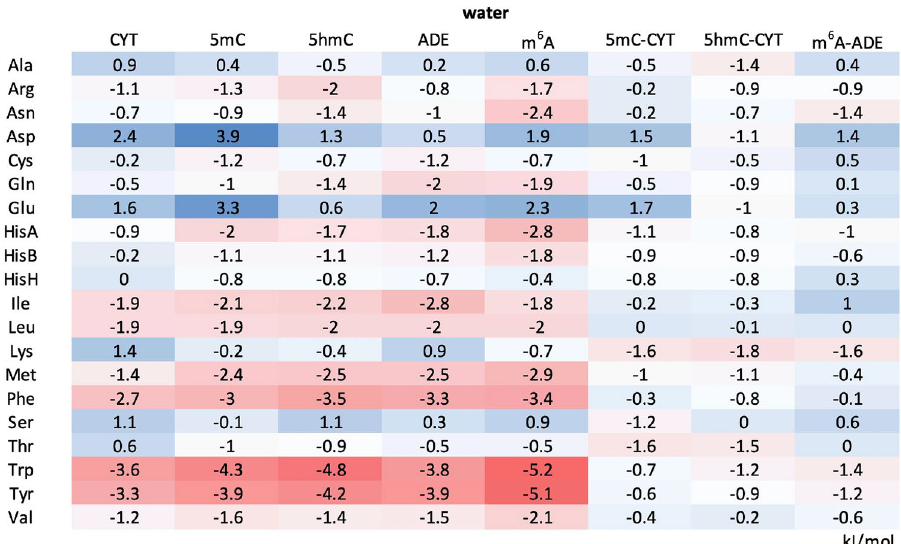
Table 1. ΔG binding in water between protein side chains and CYT, 5mC, 5hmC, ADE or m 6 A, together with ΔΔG binding of modified nucleobases with respect to their standard counterparts. The values for CYT and ADE were taken from de Ruiter et al. 12 . All values are given in